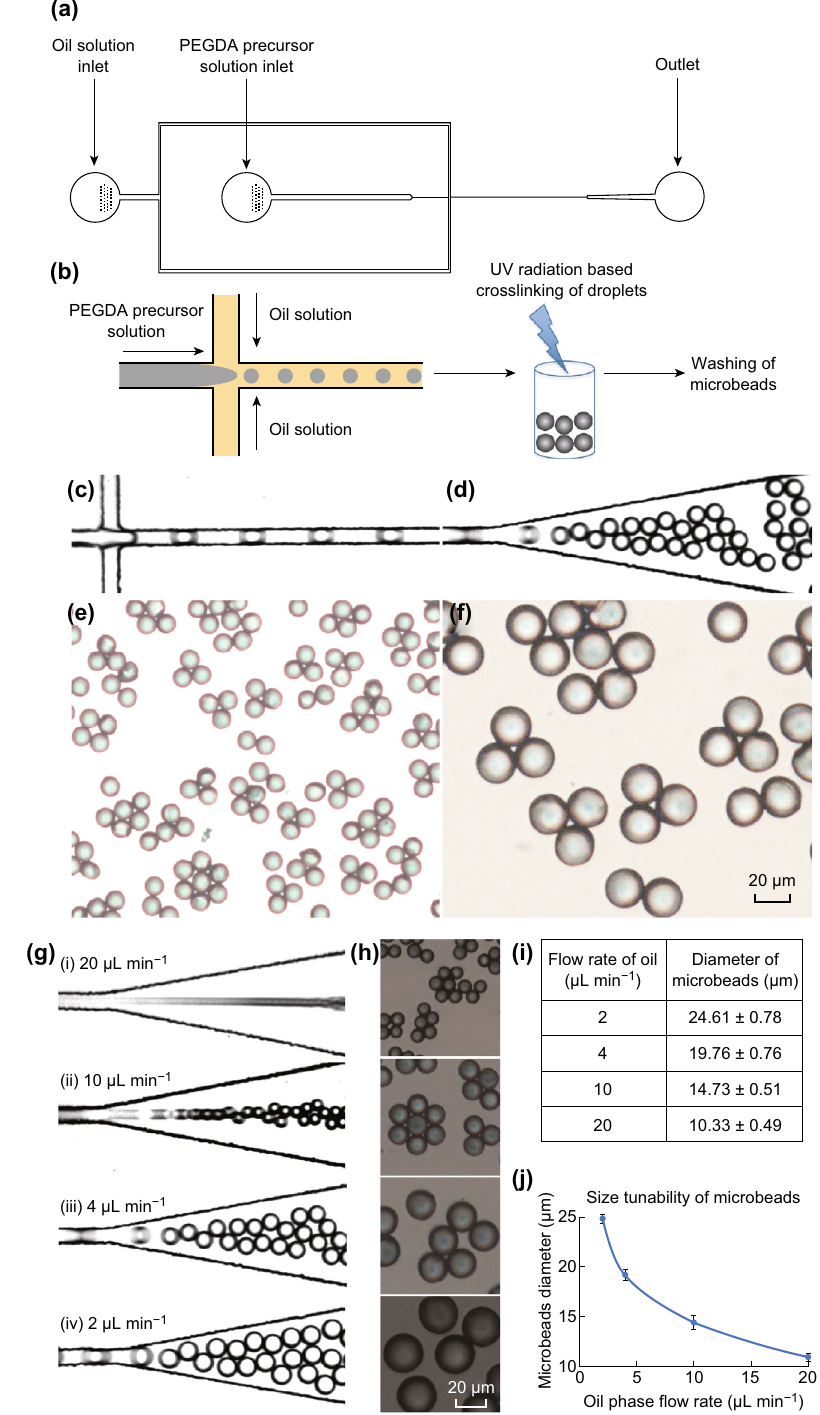
Fig. 3 Droplet microfluidic-assisted synthesis of microbeads. a AutoCAD design of the droplet microfluidic device. b Schema showing mechanism of droplet microfluidic-based microbeads synthesis. c, d Bright field microscopy images showing the production of hydrogel using microfluidic device and e, f bright field microscopy images of microbeads formed after crosslinking the hydrogel at 10 9 and 20 9 magnifications. g Formation of hydrogel in the microfluidic channel at different flow rates of oil, and h corresponding bright field microscopy images (at 40 9 , exposure = 10 ms, gain = 4 9 ) of microbeads formed. i Diameters of microbeads formed under the different oil flow rates, and j corresponding graph to show the relationship with different oil flow rates (data represent mean ± SD; n = 50